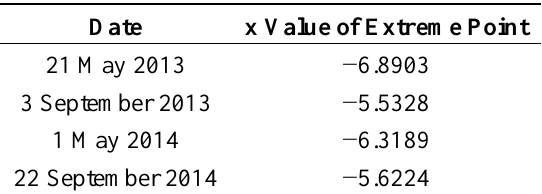
Table 5. The x value of extreme value